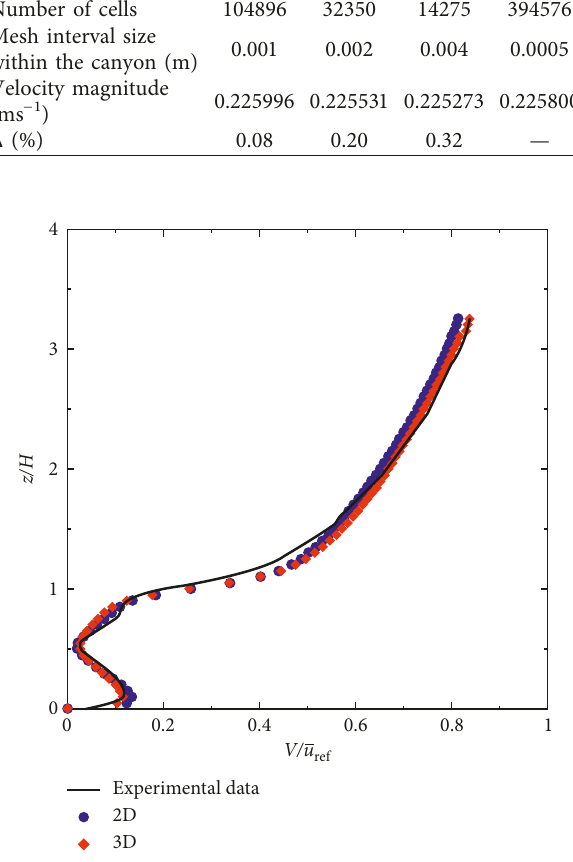
Figure 6: Vertical profiles, passing through the center of the ninth canyon, of the nondimensional velocity magnitude calculated using the 2D (blue circles) and the 3D (red diamonds) models for AR The continuous line refers to the experimental data. The height is normalized by the building height, H